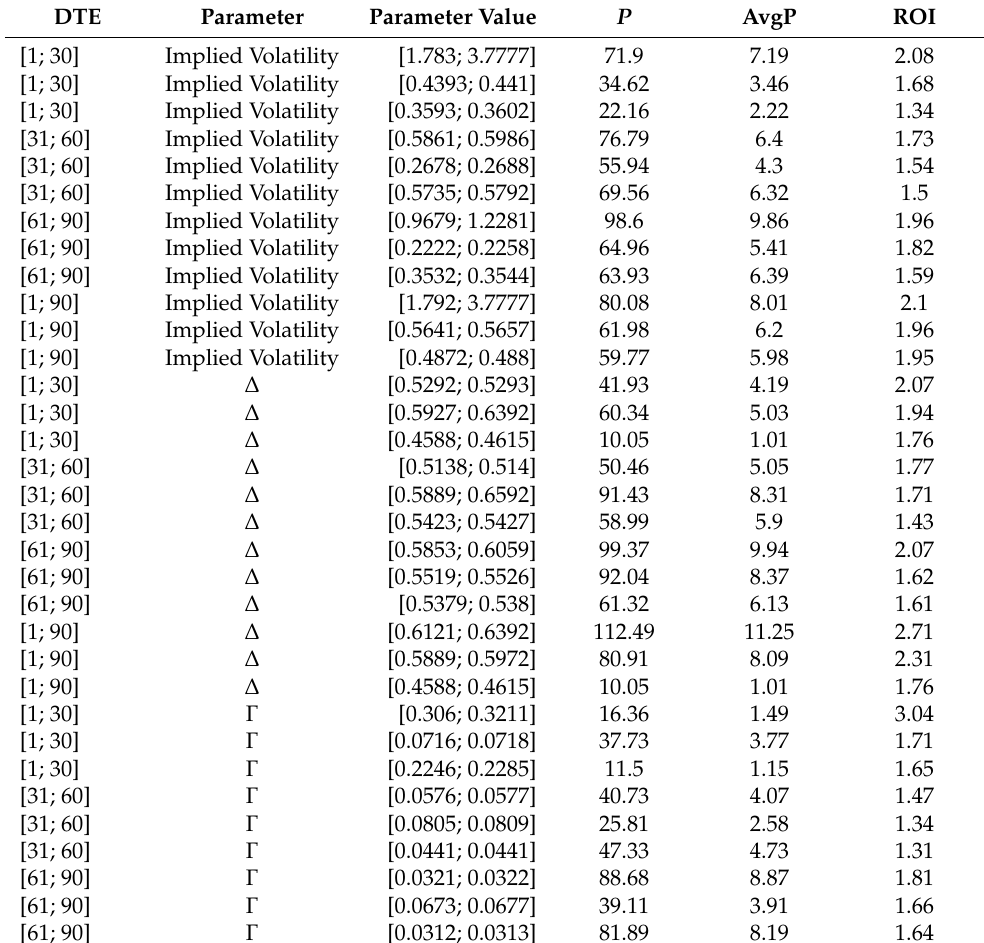
Table A3. Warto´sci wska´zników P, AvgP i ROI dla najlepszych reguł uzyskanych ze wzgl˛edu